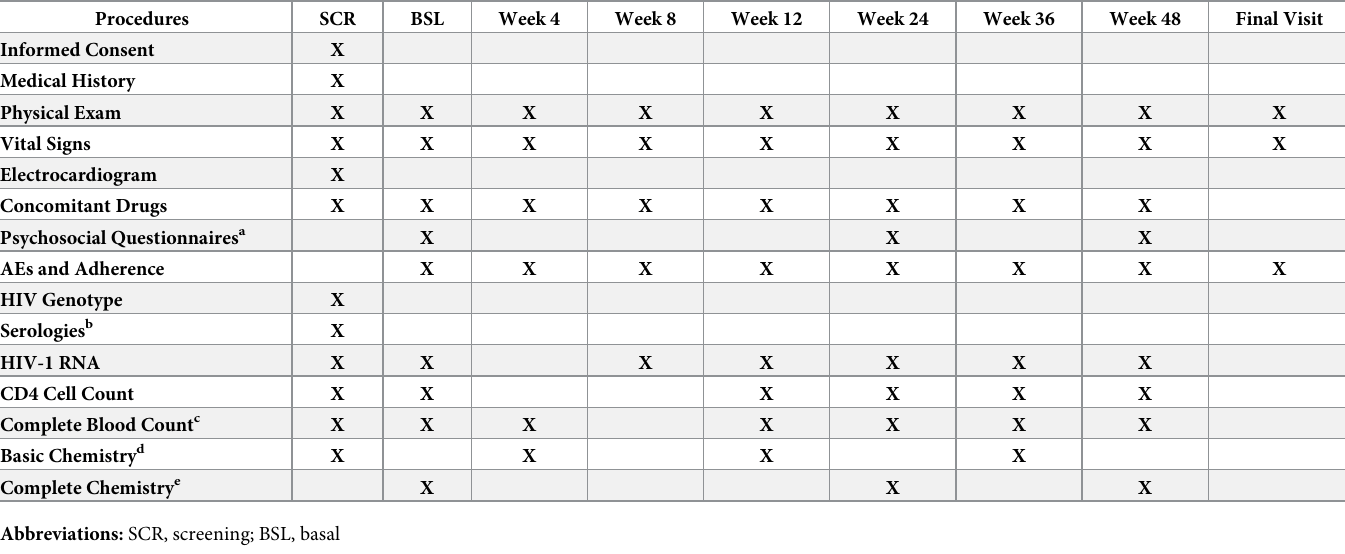
Table 1. Schedule of procedures.